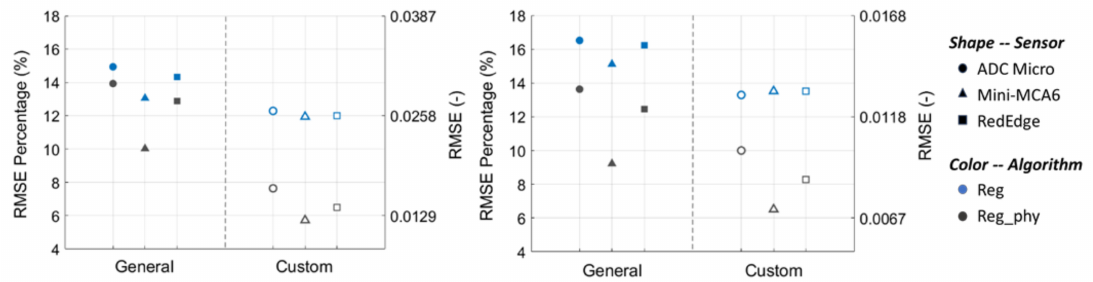
Figure 8. RMSE percentages of the general and custom NTB model-based estimated albedos of asphalt ( left ) and wooden slat ( right